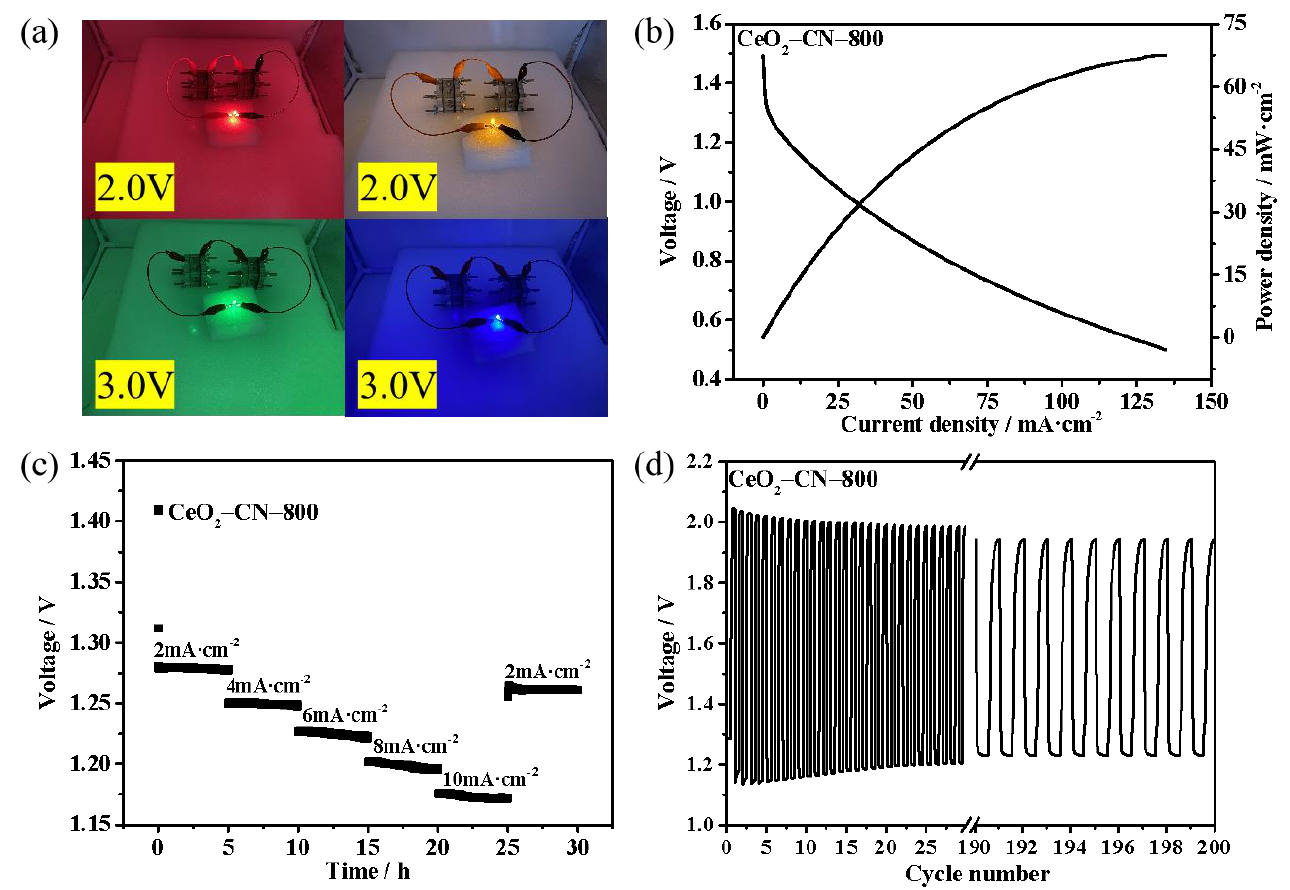
Figure 5. ( a ) Images of the Zn–air battery, assembled with CeO 2 –CN–800 as the catalyst, illuminating colored LED lights. ( b ) Polarization and power density curve of the battery. ( c ) Rate discharge curves of the battery for different current densities. ( d ) Charge–discharge cycle curve of the battery at 2 mA·cm −2 .